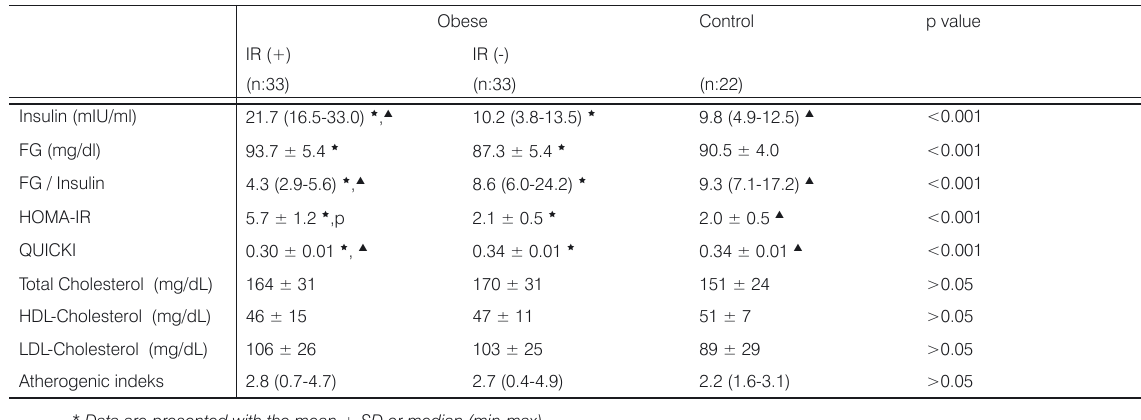
Table 2. Results of laboratory tests of obese and non-obese children.